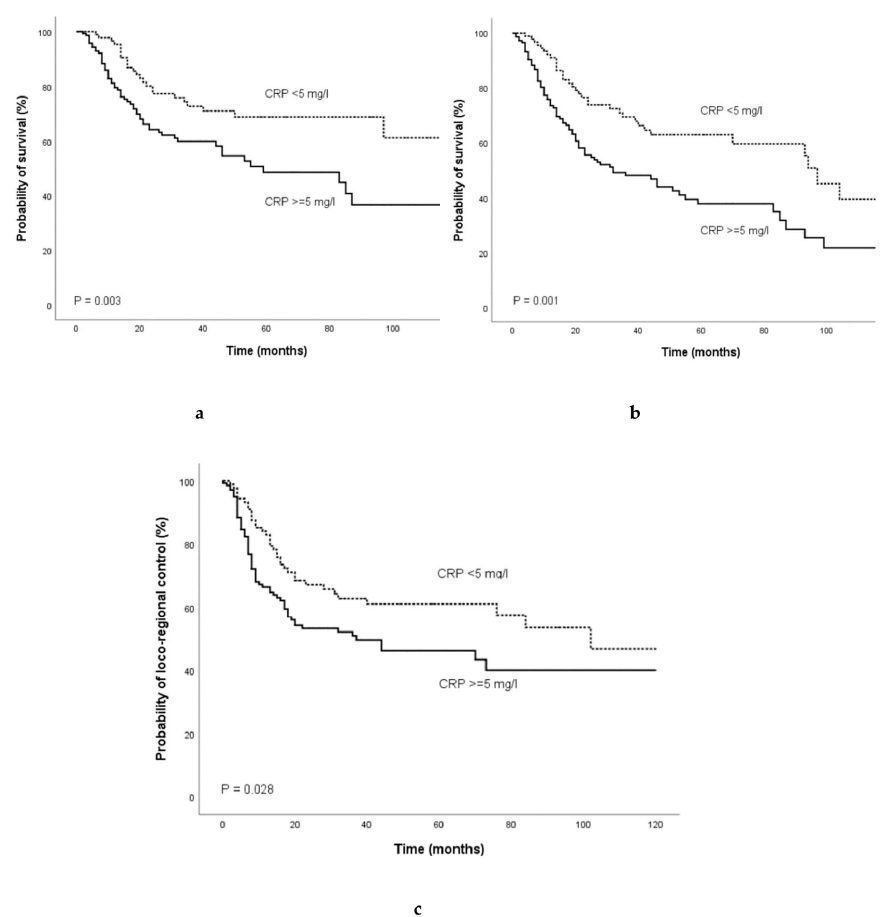
Figure 2. Kaplan-Meier curves for ( a ) cancer-specific survival, ( b ), overall survival, and ( c ) loco-regional control in patients treated with definitive (chemo-) radiotherapy categorized by the pre-treatment CRP level. Abbreviation: CRP, C- reactive protein. Table 4. Multivariate analysis of clinical-pathological parameters for the prediction of cancer-specific survival, overall survival and loco-regional control in patients treated with definitive (chemo-) radiotherapy. Criterion